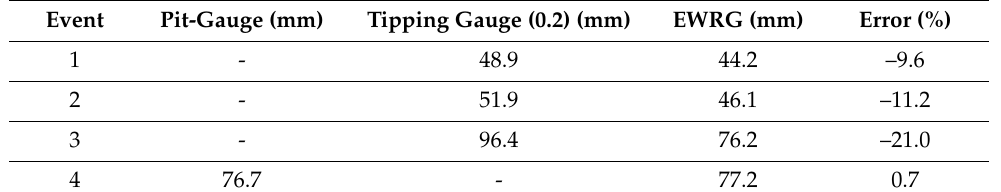
Table 2. Error comparison of total cumulative rainfall between the EWRG and ground-based equipment (Pit-Gauge, Tipping gauge).